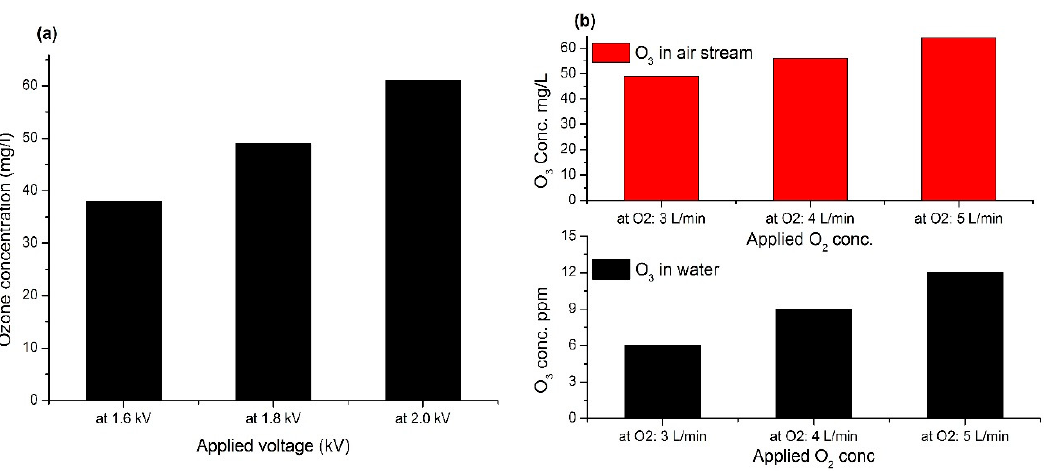
Figure 4. ( a ) The effect of voltage on the production of ozone, ( b ) The variation in the ozone concentrations in air and water